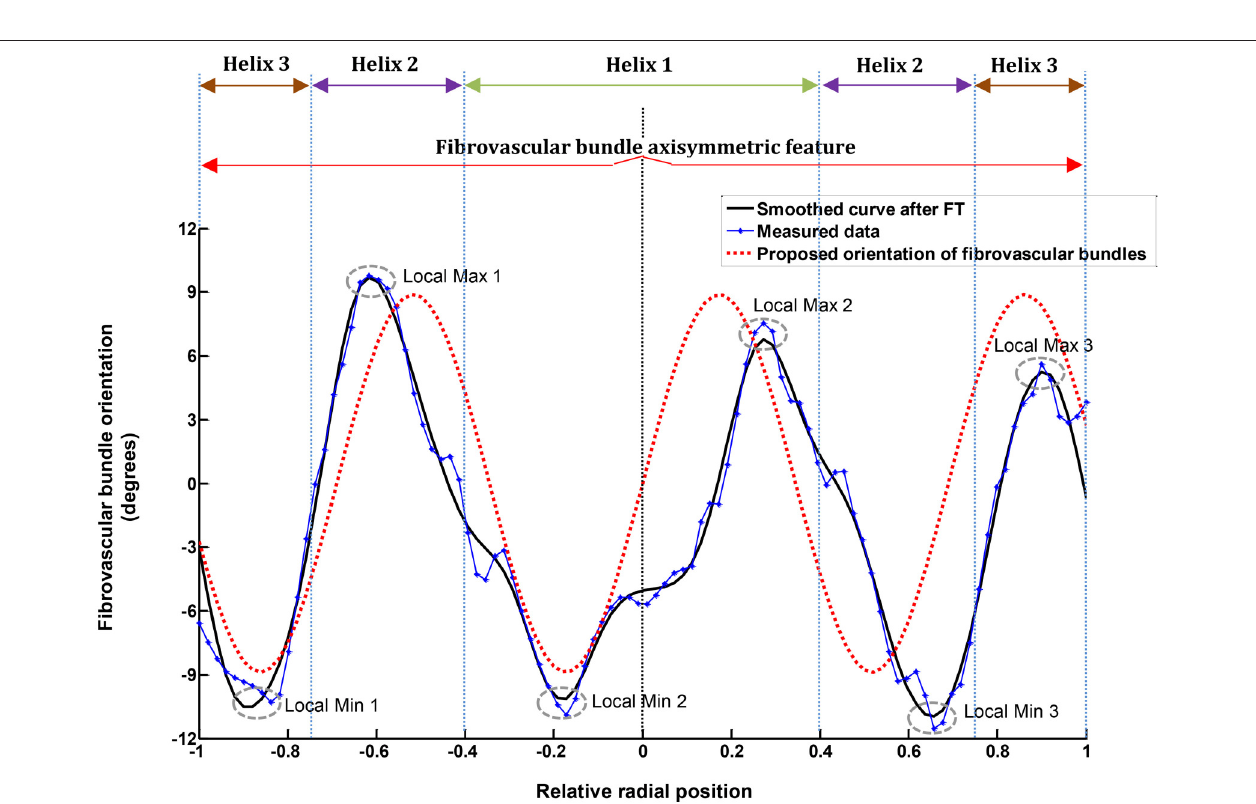
FIGURE 4 | Measured, attenuated (after applying FT), and proposed tangential fibrovascular bundle degree of orientation for palm 13 (Fiji) at 12.4m high. The characteristic cocowood fibrovascular bundle degree of orientation proposed herein (i.e., the red segmented curve) provides similar results to the actual measurements for the given palm; it also shows the axisymmetric and triple helix configurations of the fibrovascular bundles.